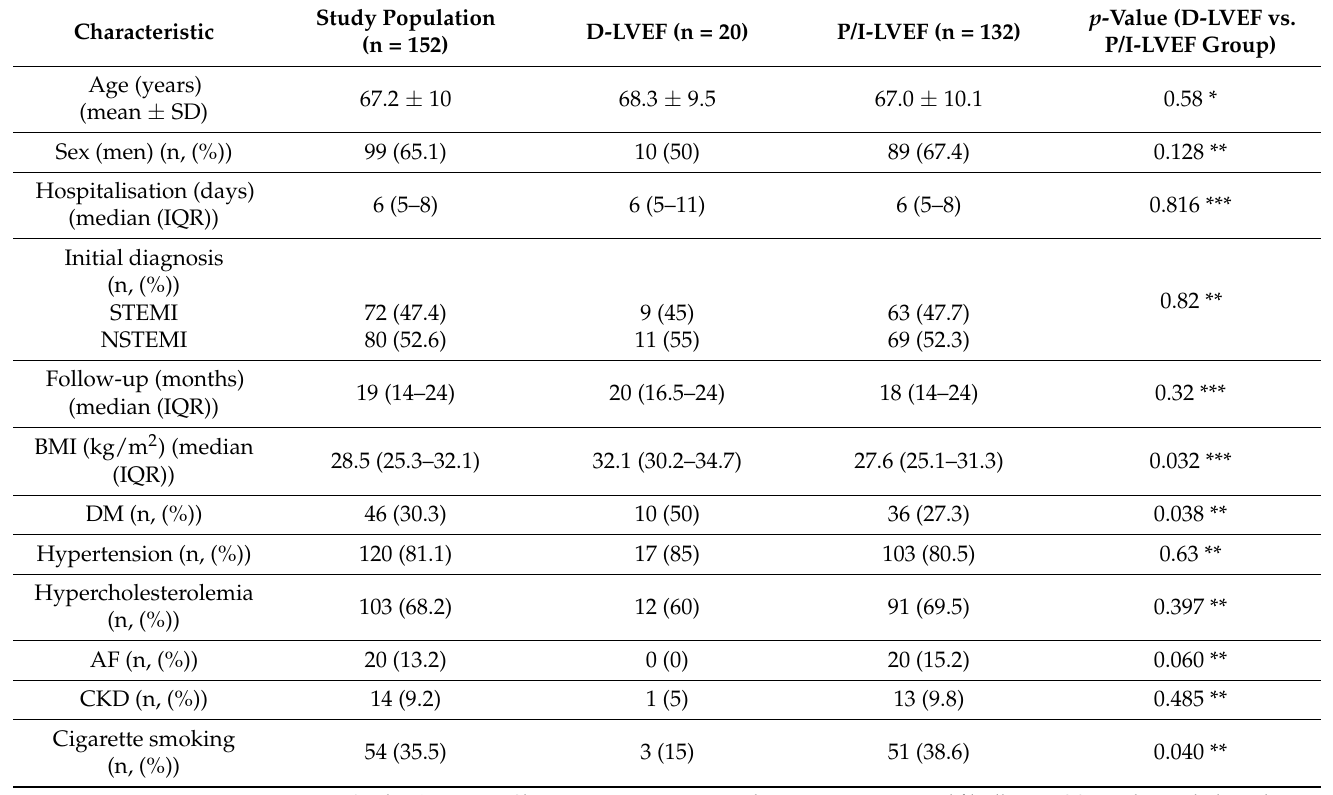
Table 1. Baseline characteristics of the study